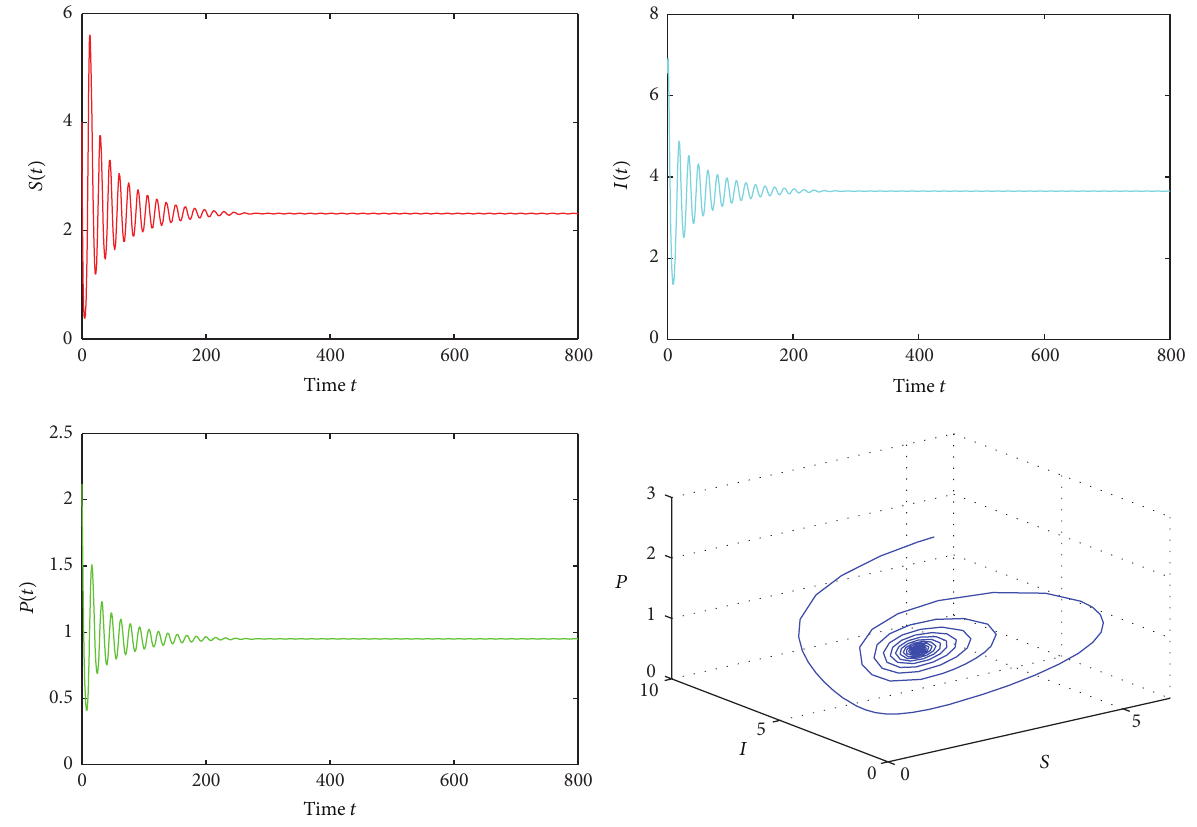
Figure 1: 𝐸 ∗ is asymptotically stable when 𝜏 1 = 0.45 < 0.5148 = 𝜏 10